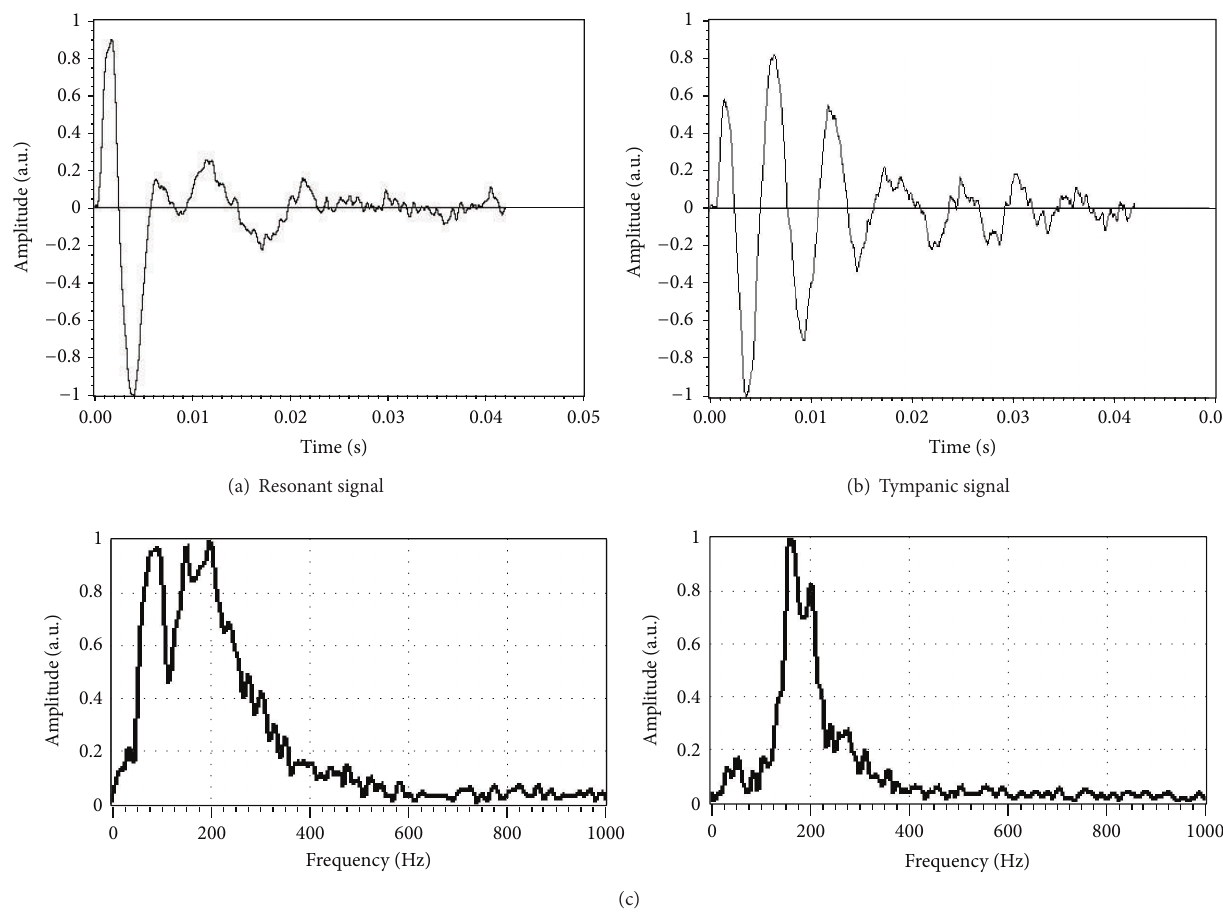
Figure 1: Two examples of audible percussion signals collected from healthy volunteers: (a) Signal from the left subclavicular area (“resonant” character); (b) signal from the left abdominal area (“tympanic” character). The normalized spectra of both signals are shown in